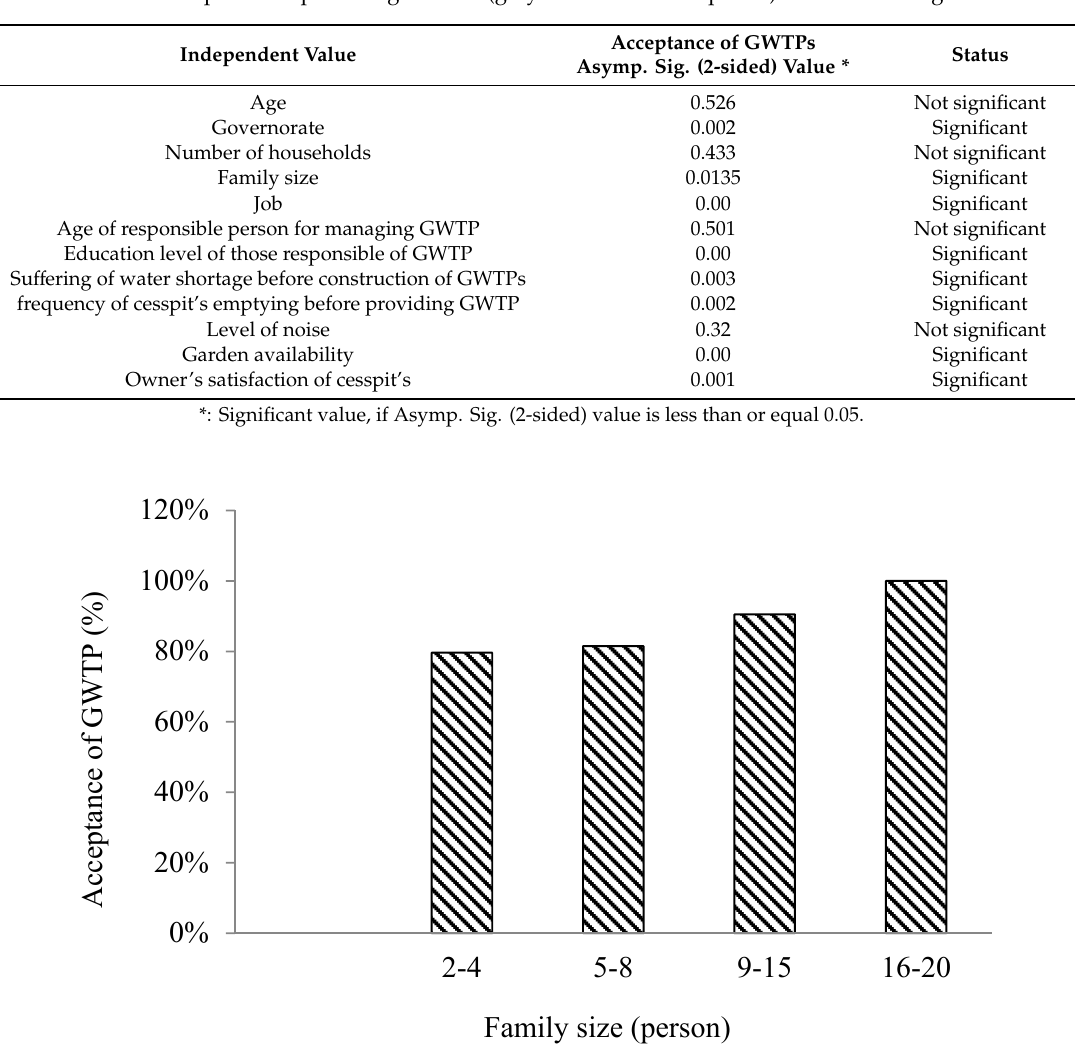
Figure 6. Acceptance of GWTPs for reuse in irrigation vs. family size.